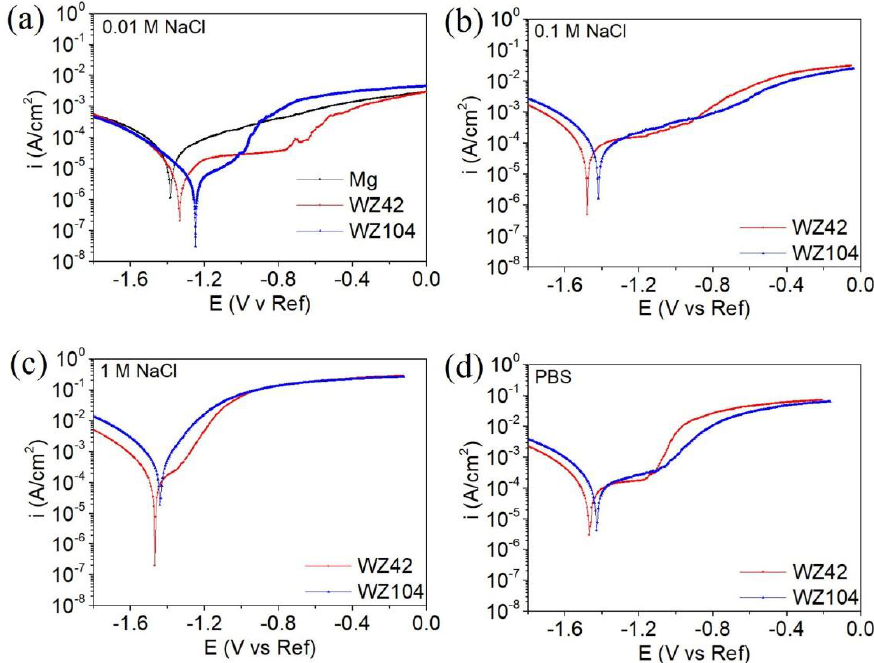
Figure 5. Potentiodynamic curves obtained for the investigated materials after 1 h of immersion in